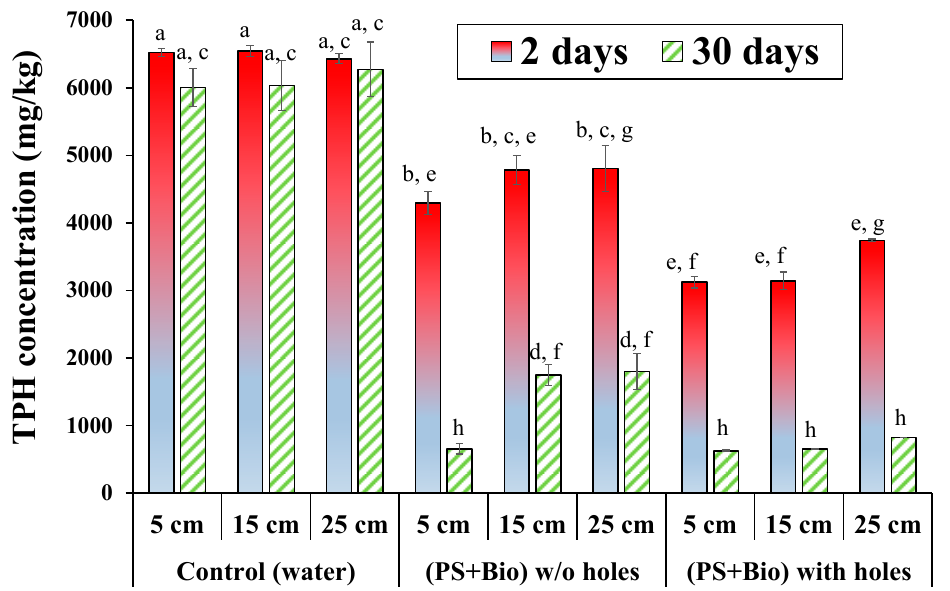
Figure 4. Residual TPH concentrations at three depths after PS oxidation (2 days) followed by biodegradation (Bio) (30 days). The different letters ( a – h ) above the bars indicate significant differences ( p < 0.05, Tukey’s test).